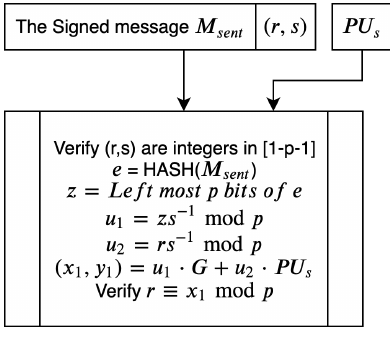
Figure 15. Receiver verifies signed